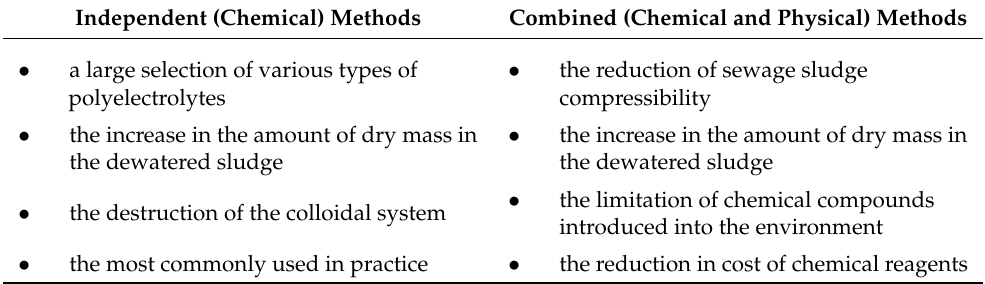
Table 1. Advantages of independent and combined methods of sewage sludge